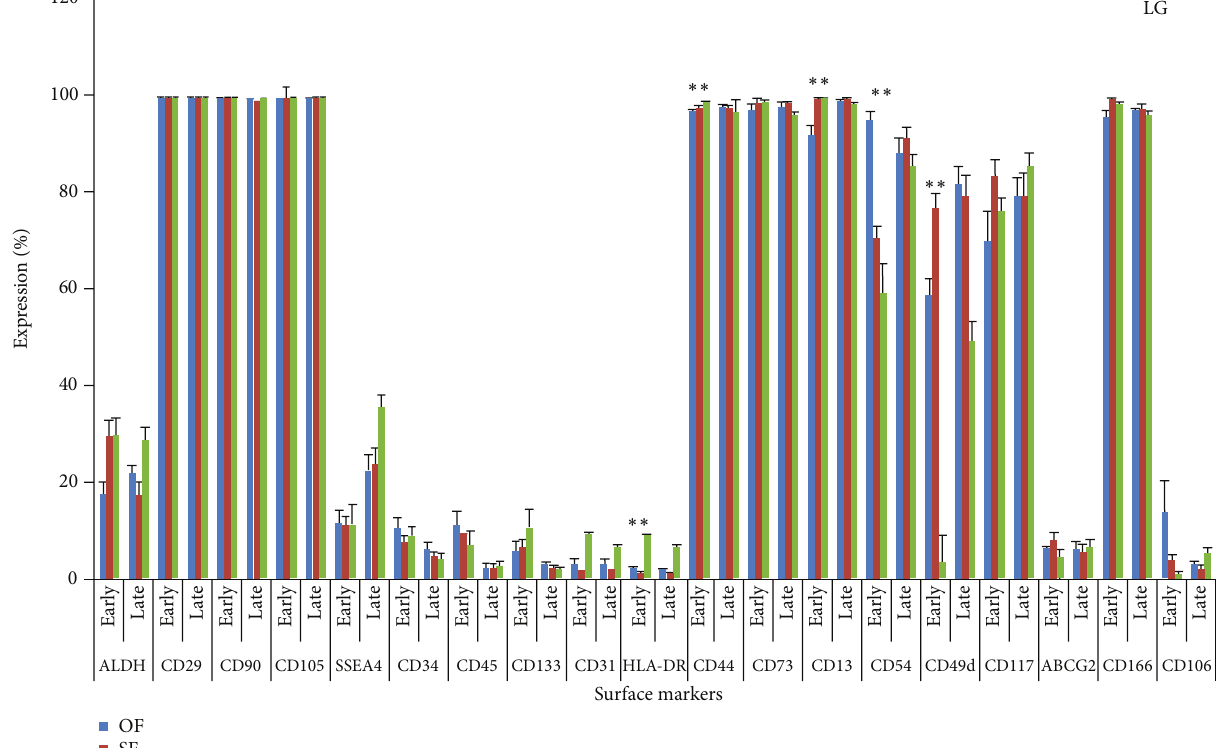
Figure 4: Marker expression profiling of MSCs cultured in DMEM-Low Glucose (DMEM-LG). Comparative Surface antigenic profiling of MSCs derived from omentum fat, subcutaneous fat, and bone marrow at early (P3) and late (P20) passages cultured in DMEM-LG.